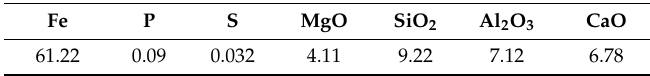
Table 2. Main chemical composition of iron concentrate (%).